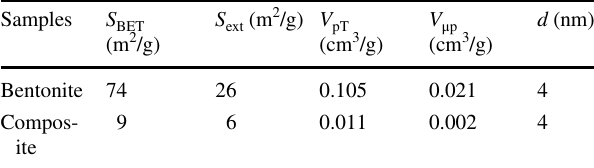
Table 2 Textural properties of bentonite and composite Samples